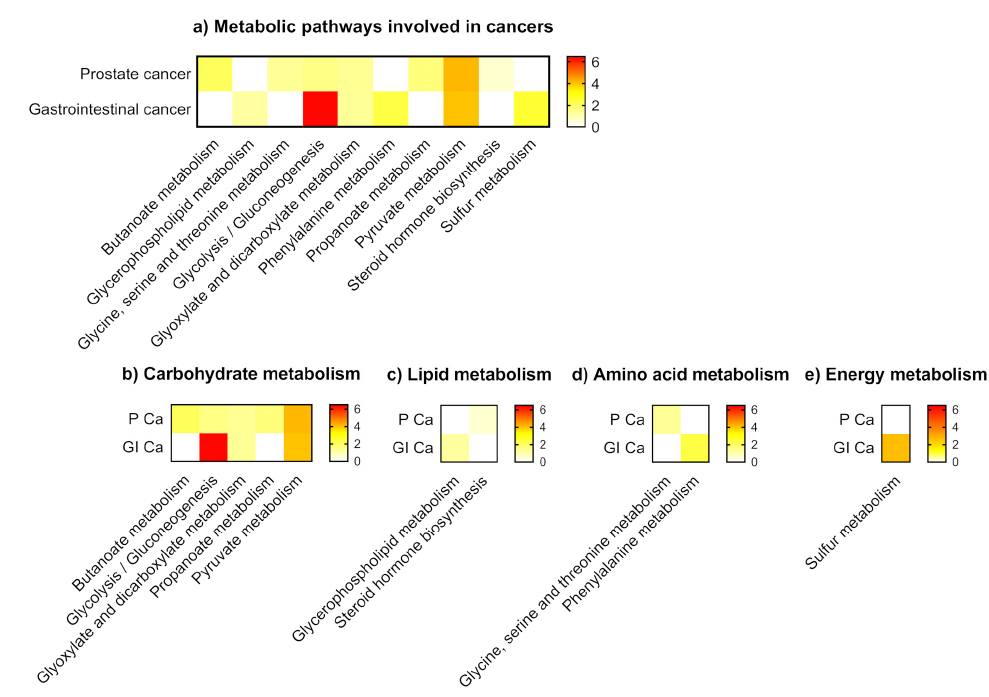
Figure 4. Metabolic pathways involved in cancers. ( a ) All metabolic pathways ( b ) Carbohydrate metabolism ( c ) Lipid metabolism ( d ) Amino acid metabolism ( e ) Energy metabolism. NOTE: P Ca: prostate cancer; GI Ca: gastrointestinal cancer. Gastrointestinal cancer had a greater association with carbohydrate metabolism and energy metabolism compared to prostate cancer, suggesting different underlying metabolic profiles of these cancers.